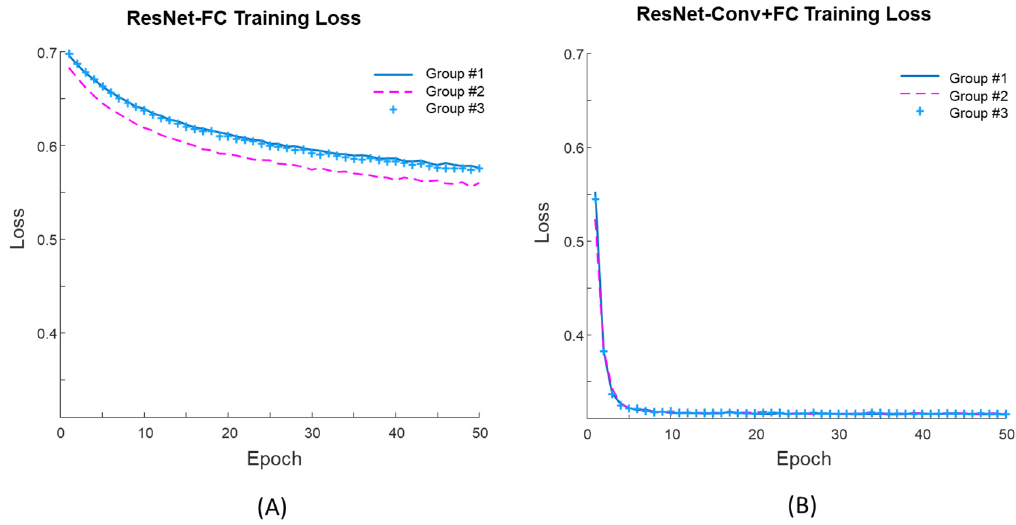
Figure 7. Training loss from three groups for ( A ) ResNet-FC and ( B )